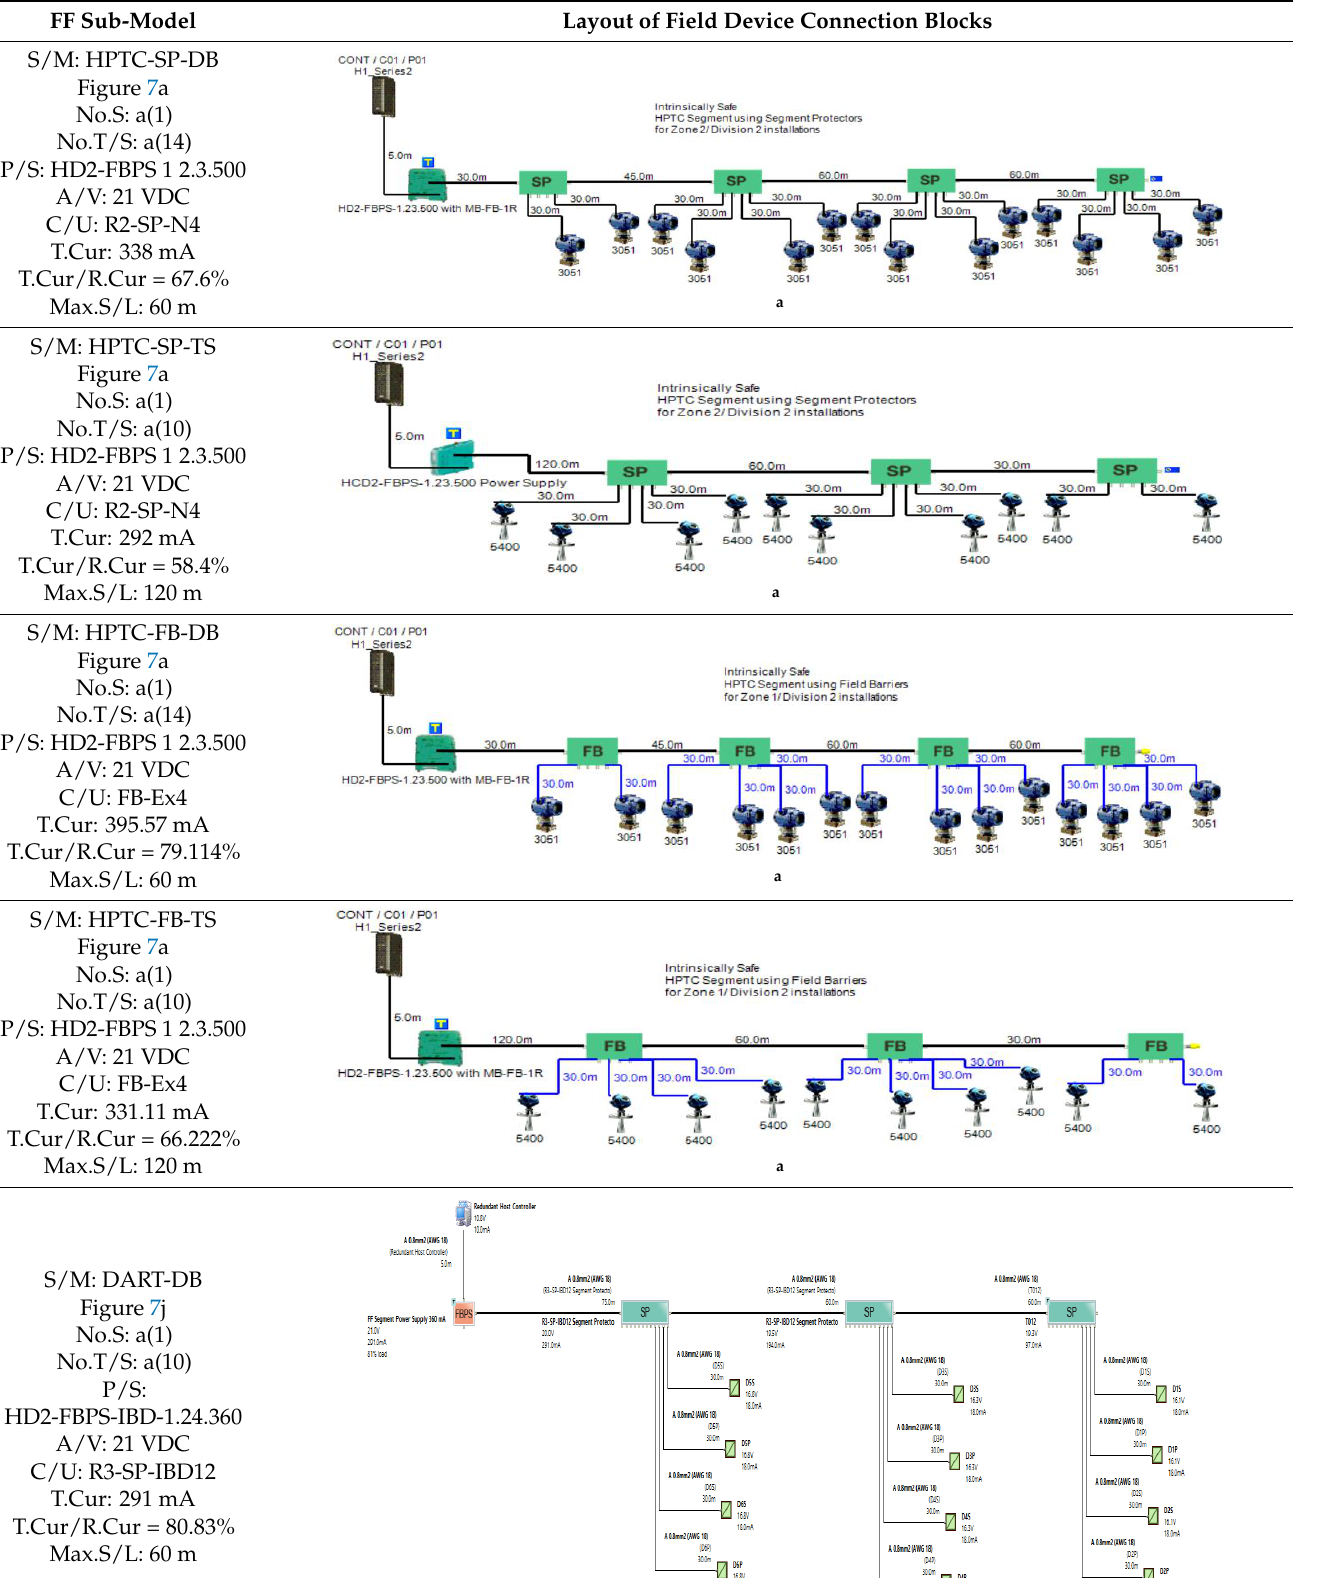
Layout of Field Device Connection Blocks